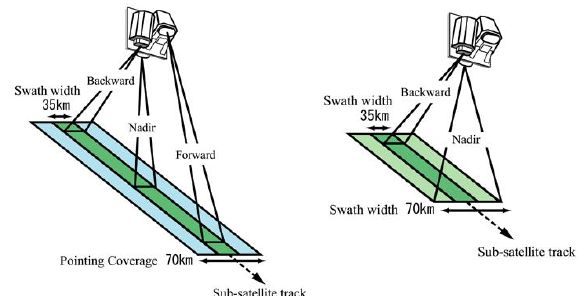
Figure 1. Observation geometries of PRISM triplet observing mode (OB1, left), and stereo (by nadir plus backward) observing mode (OB2, right) .